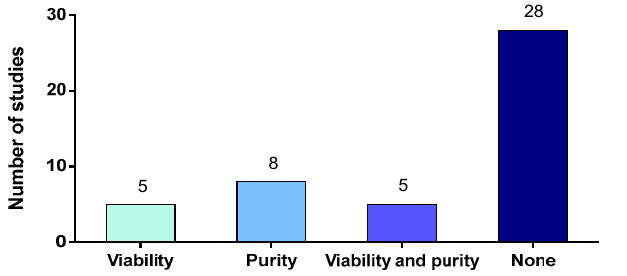
Figure 3. Number of studies evaluating neutrophil purity, viability or both among those addressing S. suis in vitro interactions with these cells. Source: PubMed ® (from October 1987 to August S. suis in vitro interactions with these cells. Source: PubMed® (from October 1987 to August 2021). Very pure neutrophil suspensions (up to 99%) can be obtained from human or